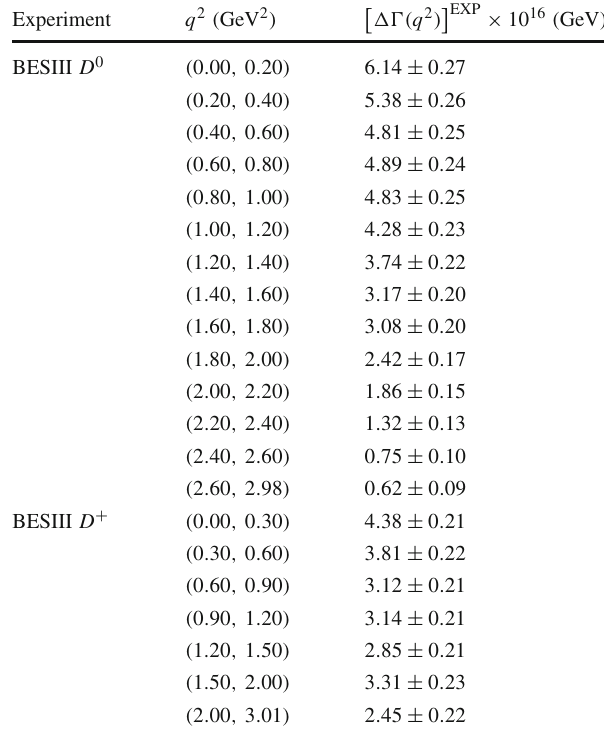
Table 5 Values of the partial decay rates transition in the q 2 -bins measured by BESIII for the D 0 → π − (cid:3)ν